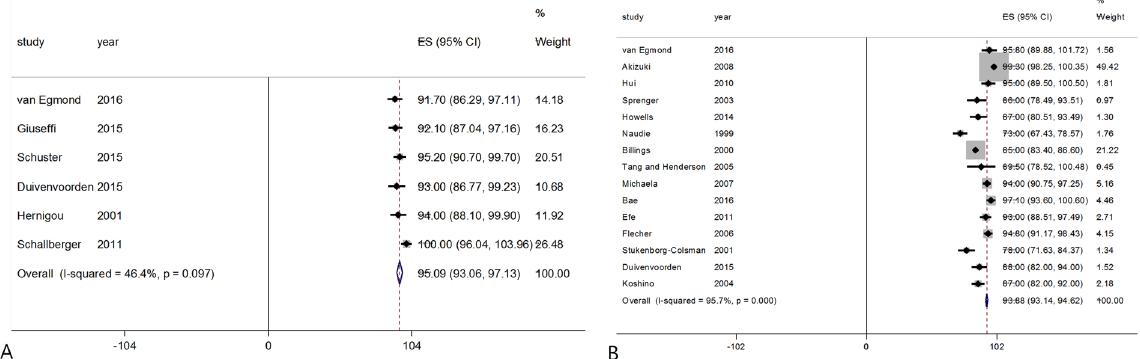
Figure 3. Forest plot showing the pooled 5-year survival rates of open wedge ( A ) and closed wedge ( B ) high tibial osteotomies.